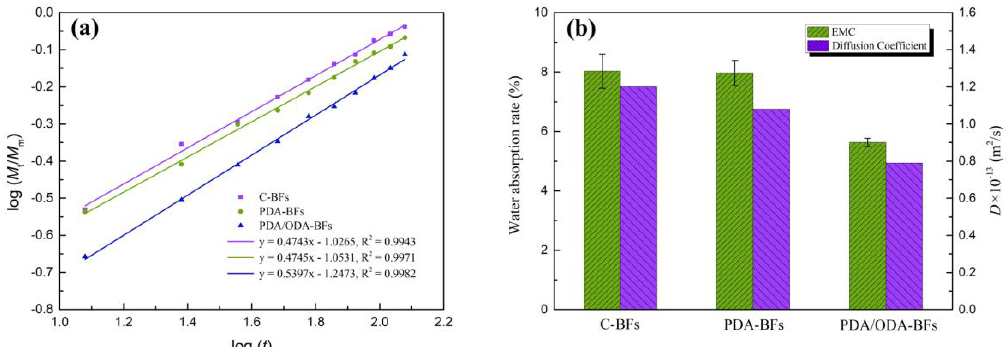
Figure 6. Effects of fiber surface modification on: ( a ) diffusion case fitting plots for BFs/PBS composites; and ( b ) equilibrium moisture content and diffusion coefficient of the composites.